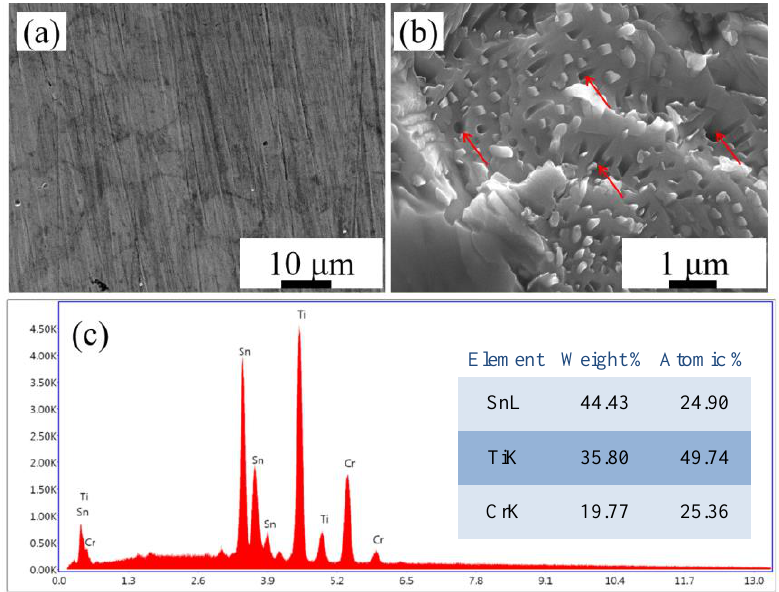
Figure 2. SEM photographs and atomic percentages of Ti 2 CrSn samples: ( a ) Sample surface morphology. ( b ) Sample fracture surface morphology and Red arrows point to submicron holes. ( c ) atomic percentages